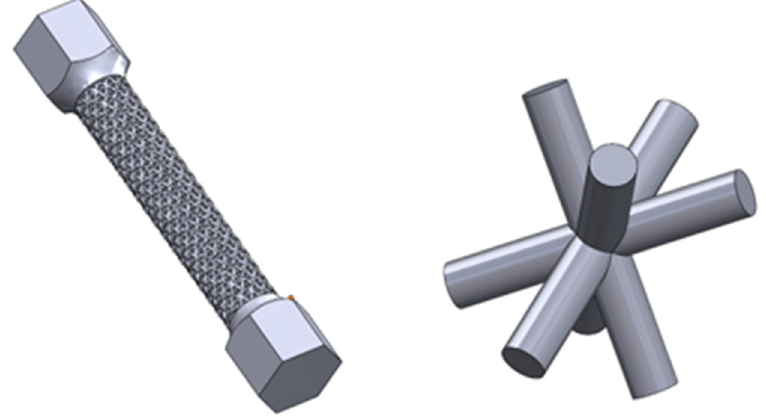
3 of 17 Figure 1. Monolithic specimen (PM_Samples).